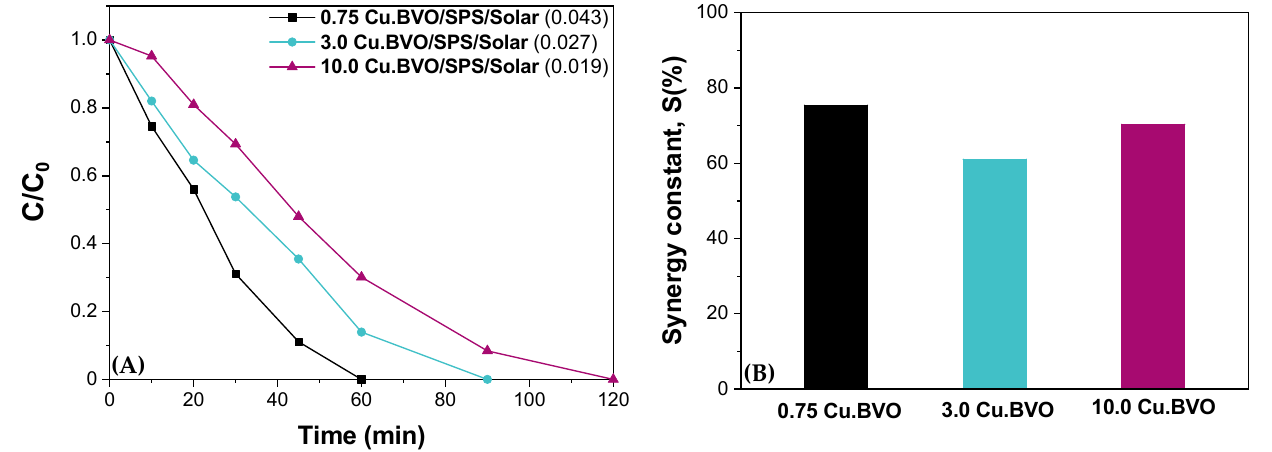
Figure 8 outlines results obtained in BW in hybrid systems for all photocatalytic ma- terials tested; SMX degradation was favored in the 0.75 Cu.BVO sample, but increasing copper loading slowed down the degradation kinetics. In contrast, the degree of syn- ergy was similar in all cases (Figure 8B), implying that it is independent of the process’s overall performance.